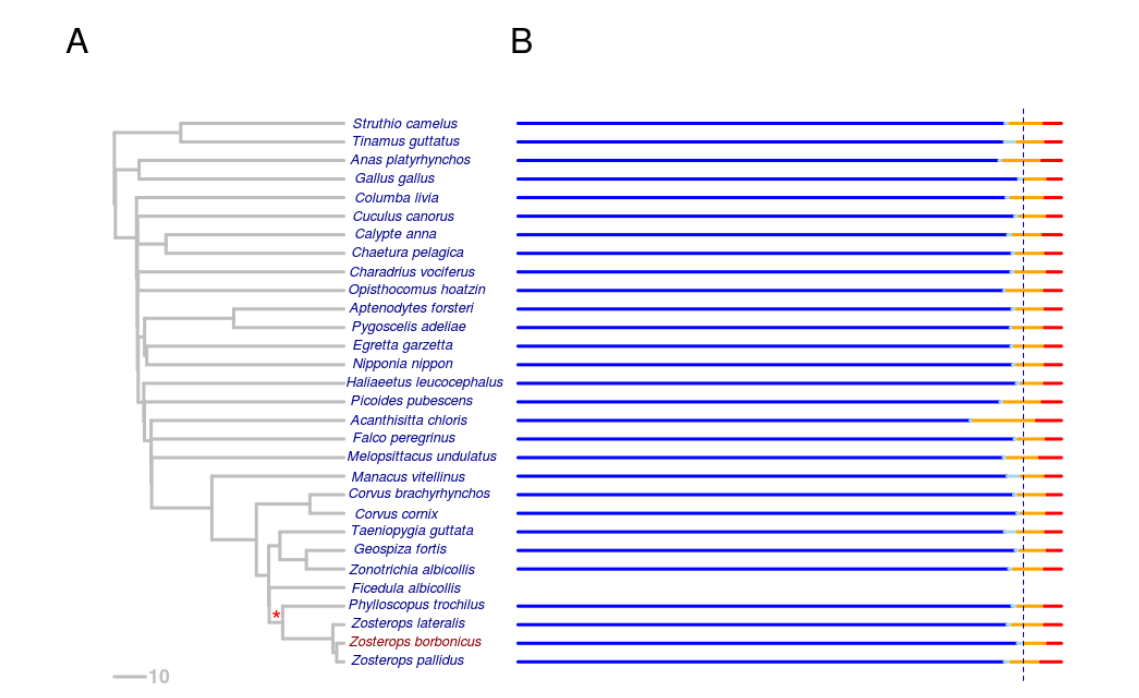
Figure S1. A) Phylogenetic tree based on all investigated avian species. The red star indicates the origin of the two neo-sex chromosomes (ancestor of Sylvioidea). B) Summary statistics of the BUSCO analysis based on the 27 genome assemblies used as input for DeCoSTAR. Blue, light blue, orange and red colors indicate single copy, duplicated, fragmented, missing genes, respectively. The blue dotted line corresponds to the cumulative proportion of complete genes (single copy and duplicated ones) found in Z. borbonicus . For unknown reasons, BUSCO analysis failed for the F. albicollis